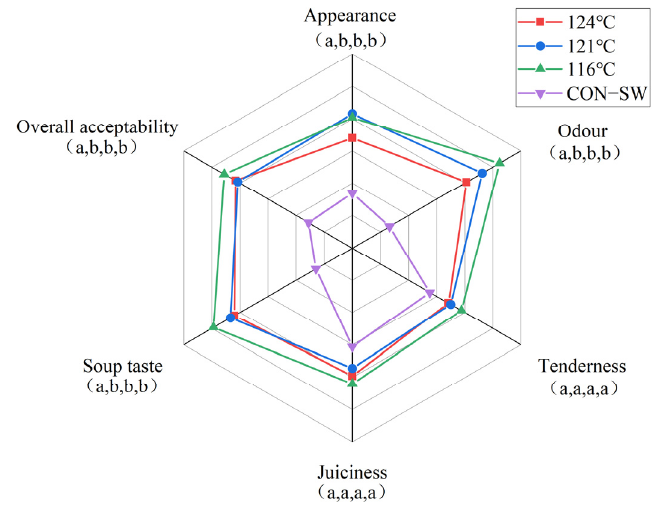
Figure 8. Sensory evaluation of poached spicy pork slice samples sterilized by radio frequency combined superheated water in three temperatures and superheated water alone in 116 ◦ C. The four letters in brackets belong to the four conditions from the center to the outside. Different lowercase letters (a–b) indicate a significant difference ( p < 0.05) within the same object.